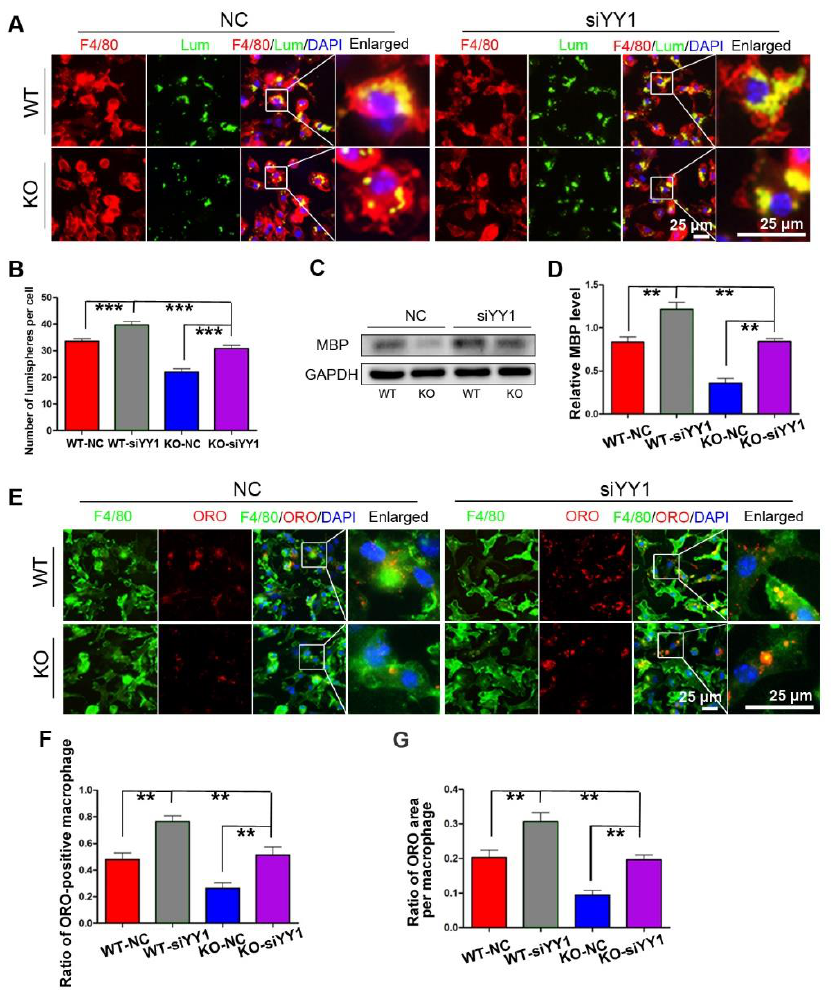
Figure 5. siYY1 transfection inhibits macrophage phagocytosis. ( A ) F4/80 immunocytochemistry with the fluorescent lumispheres and quantitative analysis ( B ). ( C ) Western blots and ( D ) quantifi- cation showing that MBP expression in the KO – siYY1 group cultured with myelin debris is more than those in the KO – NC group in vitro. ( E ) F4/80 and ORO double immunocytochemistry staining and ( F , G ) quantification of the ratio of ORO+ macrophages and the ORO+ area in each cell after the macrophages cultured with myelin debris in vitro. Data are expressed as the mean ± SEM ( n = 3 for each group, N.S p ≥ 0.05, ** p < 0.01, *** p < 0.001).